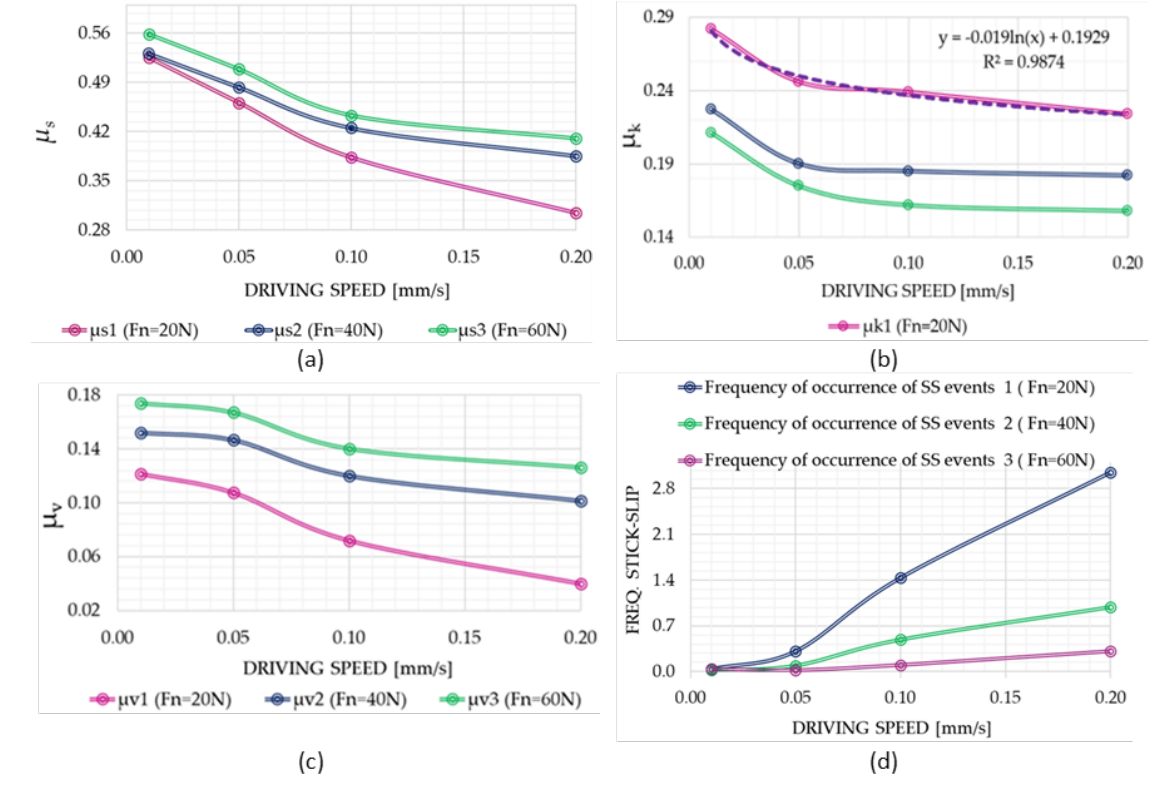
Figure 5. The influence of the driving speed and normal force on the friction coefficients: static fric-